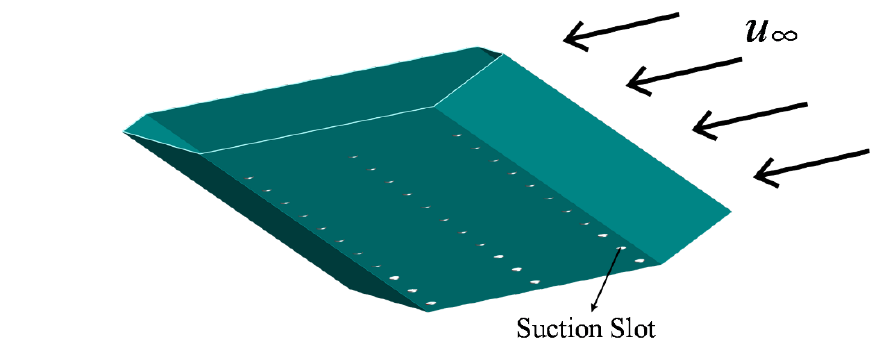
Figure 2. Suction slot arrangement.